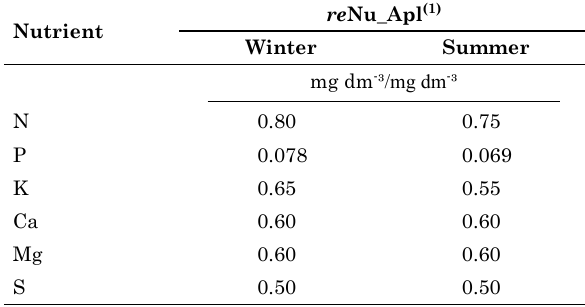
(1) Values obtained by simulation based on the relationship between nutrient extraction and supply from the soil, crop residues, and fertilizers for mean yield of each crop season, winter or